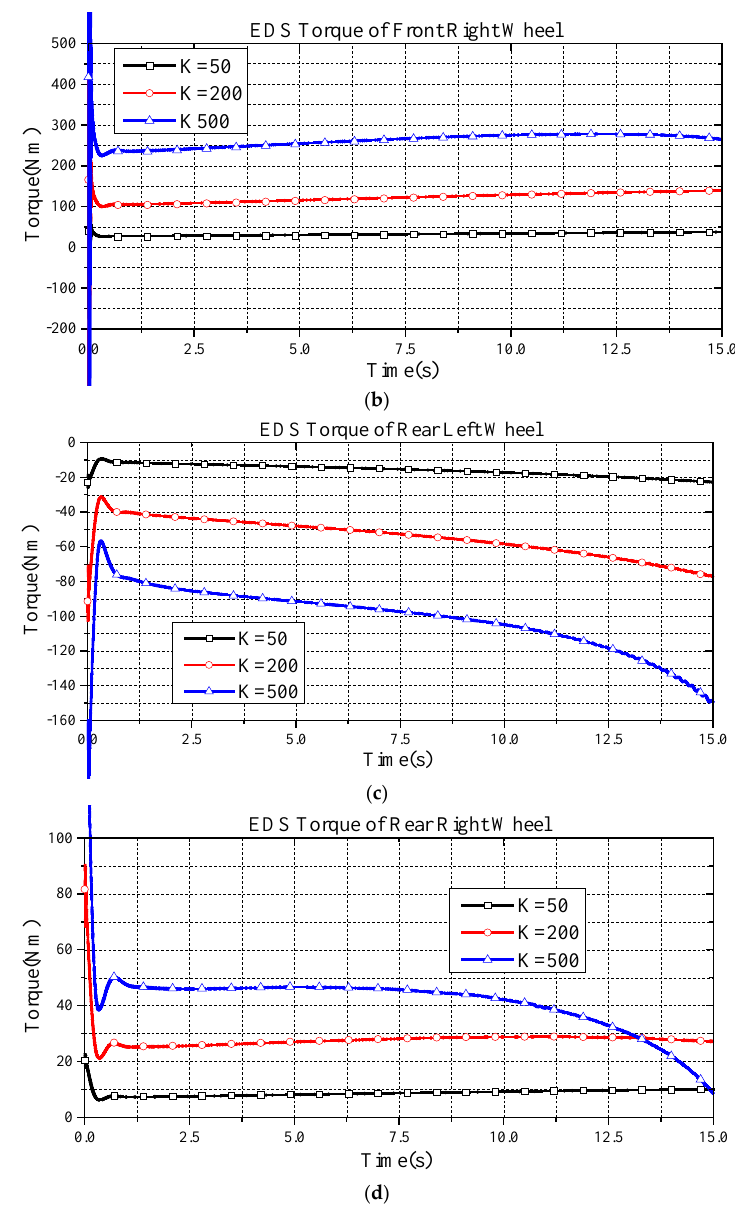
Figure 9. Adjusting torque from EDS. ( a ) Front left wheel; ( b ) Front right wheel; ( c ) Rear left wheel; ( d ) Rear right wheel.